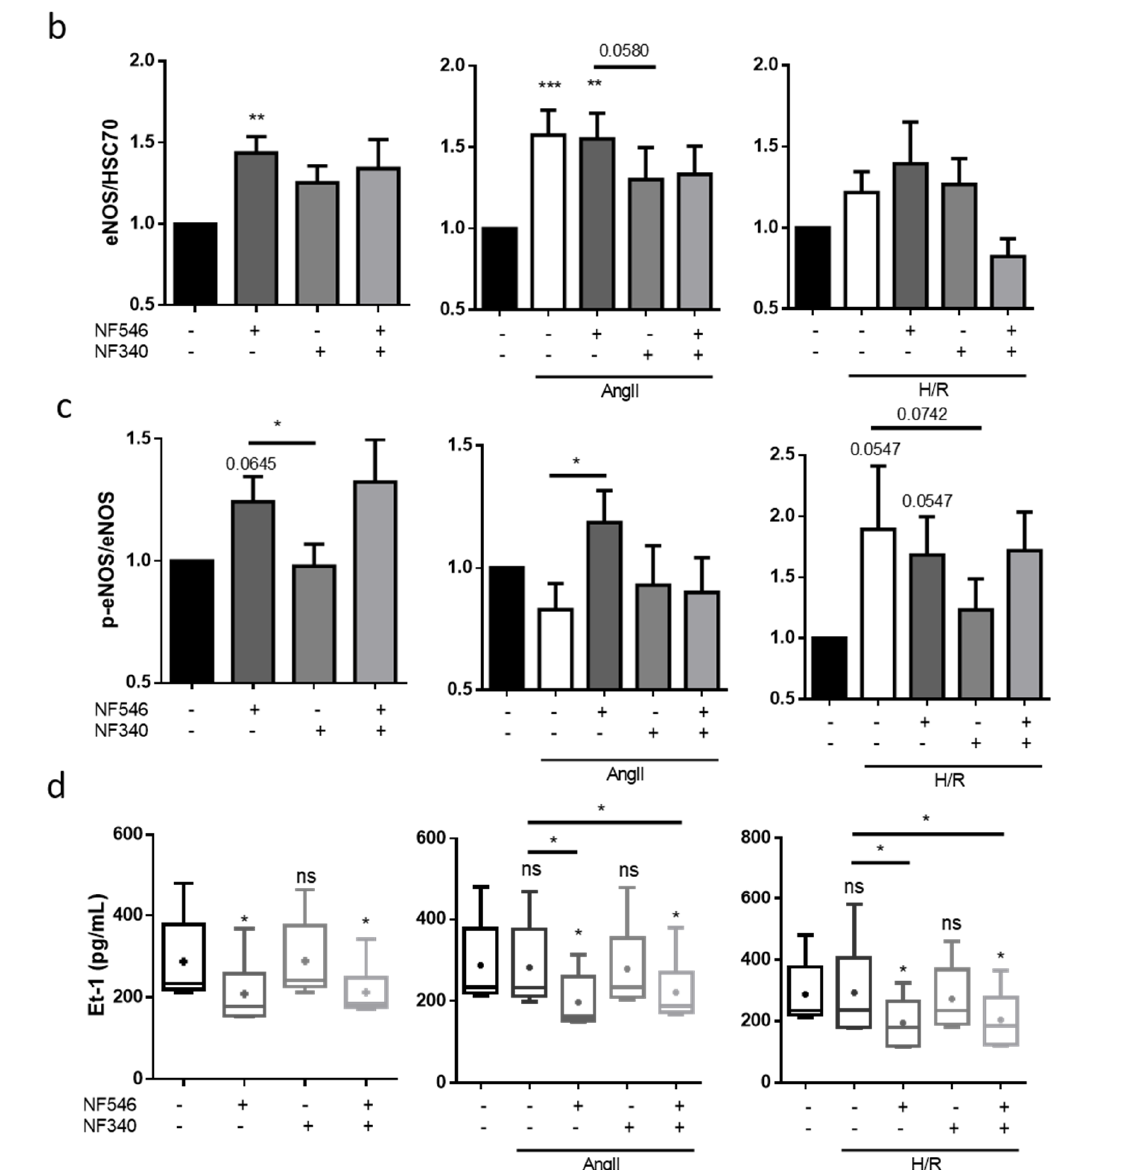
Figure 3. Vascular tone regulation by ECs is modulated by P2Y11 ligands. ( a ) P2Y11 protein expression on HUVECs was analyzed by western blot, showing a band at 50 kDa (n = 3). ( b , c ) HUVECs were incubated 30 min with basal medium, AngII (100 nM) or submitted to 5 h hypoxia followed by 30 min reoxygenation (H/R), and incubated with the P2Y11 agonist NF546 (10 µ M) or/and antagonist NF340 (10 µ M). Endothelial nitric oxyde synthase (eNOS) and p-ser1177-eNOS protein expression were analyzed by western blot. In the CTL group, NF546 increased eNOS expression (n = 13) and p-ser1177-eNOS (n = 10). In the AngII group, eNOS expression was increased in the presence of AngII; AngII+NF546 (n = 13) and p-ser1177-eNOS was increased compared to AngII condition (n = 10); and P2Y11 receptor (P2Y11R) antagonist NF340 tended to decrease eNOS expression compared to AngII condition. In the H/R group, H/R and NF546 tended to increase eNOS expression (n = 13) and increase p-ser1177-eNOS (n = 10). ( d ) HUVECs were incubated 12 h with basal medium, AngII (100 nM) or submitted to 5 h hypoxia followed by 12 h reoxygenation (H/R), and addition of P2Y11R agonist NF546 (10 µ M) and/or antagonist NF340 (10 µ M). Endothelin-1 release was evaluated in HUVECs supernatant by ELISA assay. AngII or H/R did not show significant changes in endotheline-1 (Et-1) release. In the CTL, AngII and H/R groups, P2Y11R activation by NF546 decreased Et-1 release (n = 6). * p < 0.05, ** p < 0.01 and *** p < 0.01, compared to CTL condition if not indicated. Data given as mean ± SEM and box plot as median and mean + min to